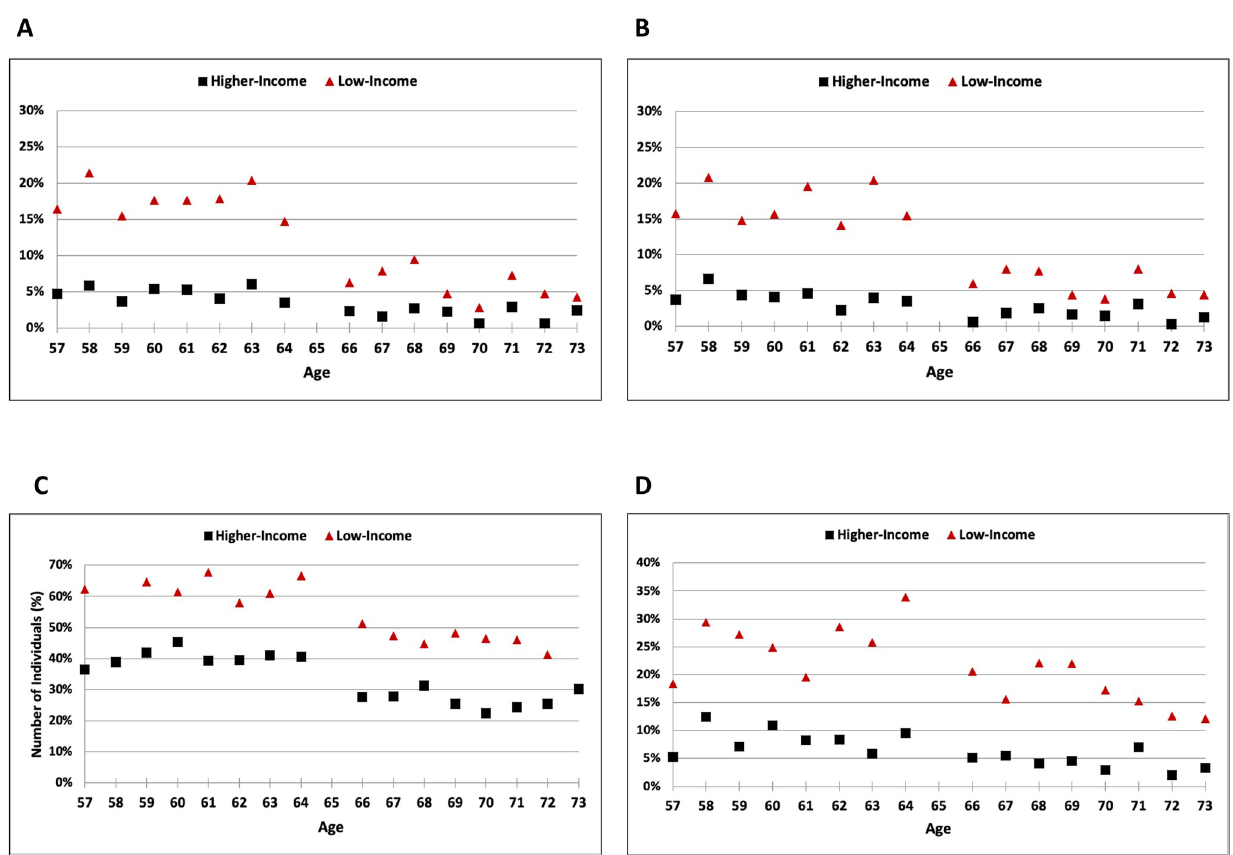
Fig 2. Measures of access and affordability by income level, age 57 to 73 years. The percentage of US adults who reported (A) delaying medical care due to cost, (B) not seeking medical care due to cost, (C) worrying about medical bills, and (D) experiencing problems paying medical bills. Remaining outcomes are shown in Figs A-F in S1 Text . (A) Delayed medical care due to cost. (B) Did not seek medical care due to cost. (C) Get sick or have accident, worry about paying medical bills. (D) Problems paying medical bills.